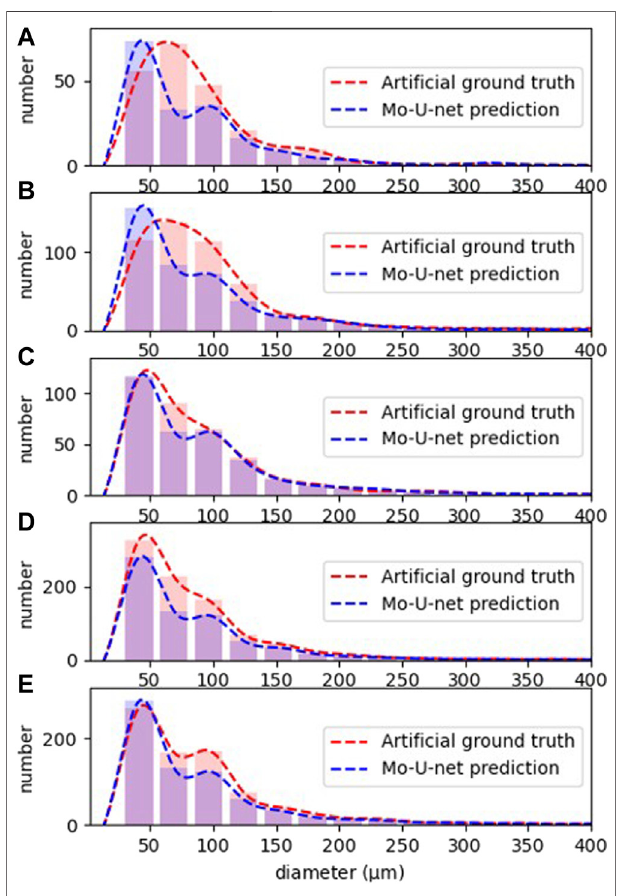
Frontiers in Physics |